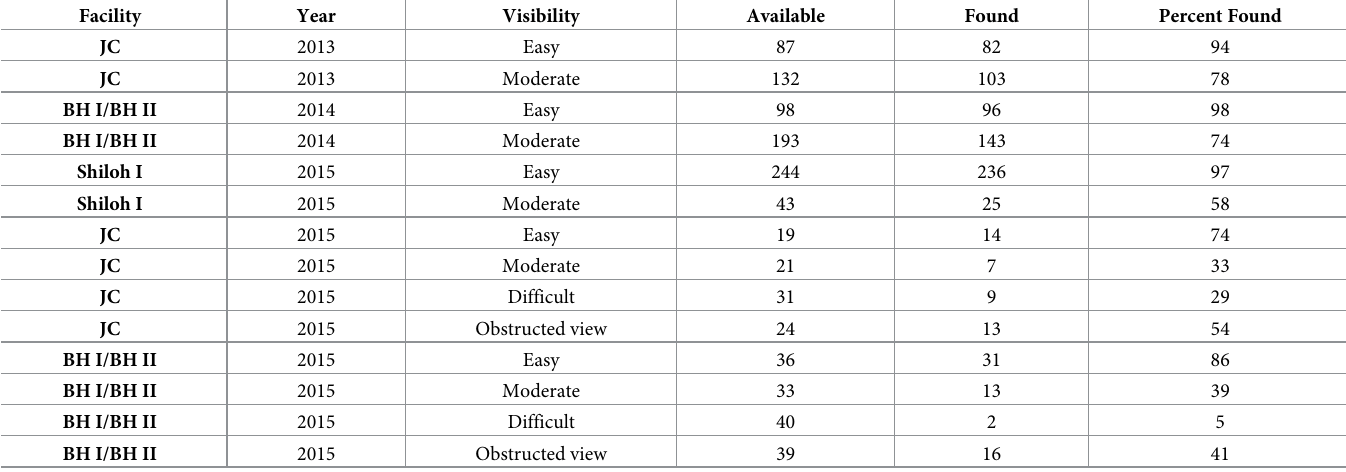
Table 3. Searcher efficiency trial results as a function of year and visibility class at the Juniper Canyon (JC), Big Horn I (BH I), Big Horn II (BH II), and Shiloh I wind energy facilities. Overall, searchers detected 76% of all decoy placements.